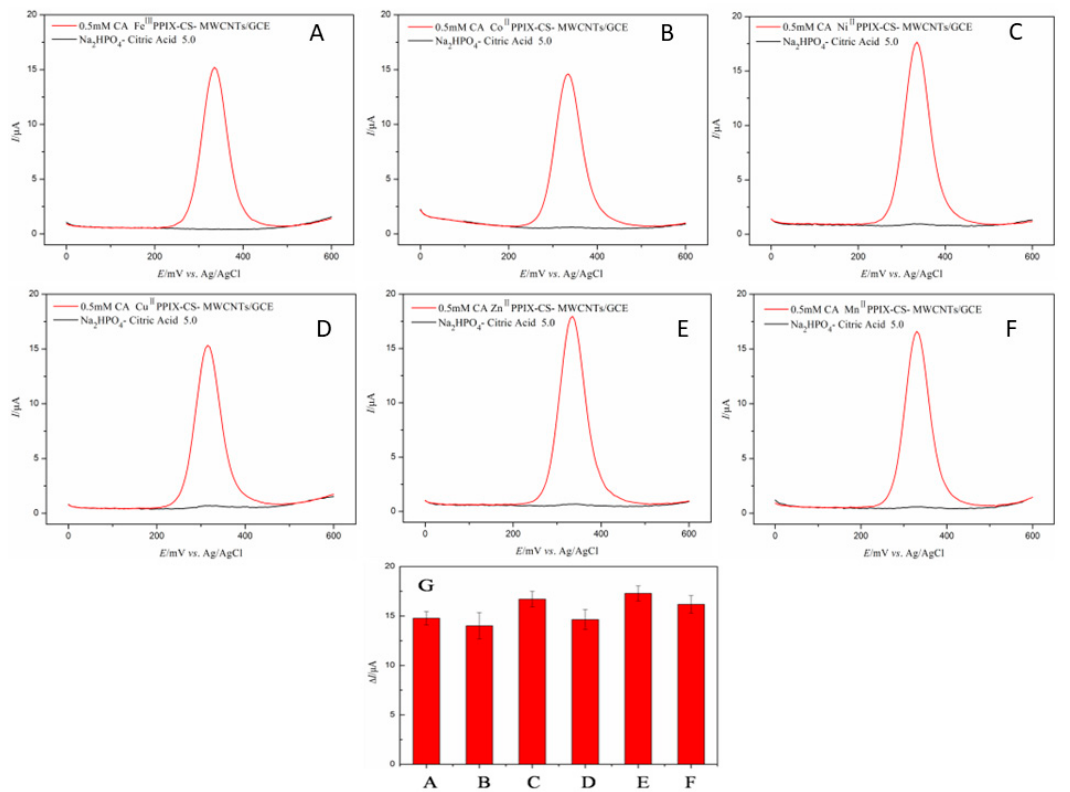
Figure 1. DPV of unmodified GCEs and GCEs modified with different Me-PPIX-CS-MWCNTs nanocomposites in 0.05 M Na 2 HPO 4 –citric acid solution (pH 5.0) containing 0.5 mM caffeic acid. ( G ) Histogram of oxidation-peak currents of ( A – F ). (Error bars = ± standard deviation, n = 5).